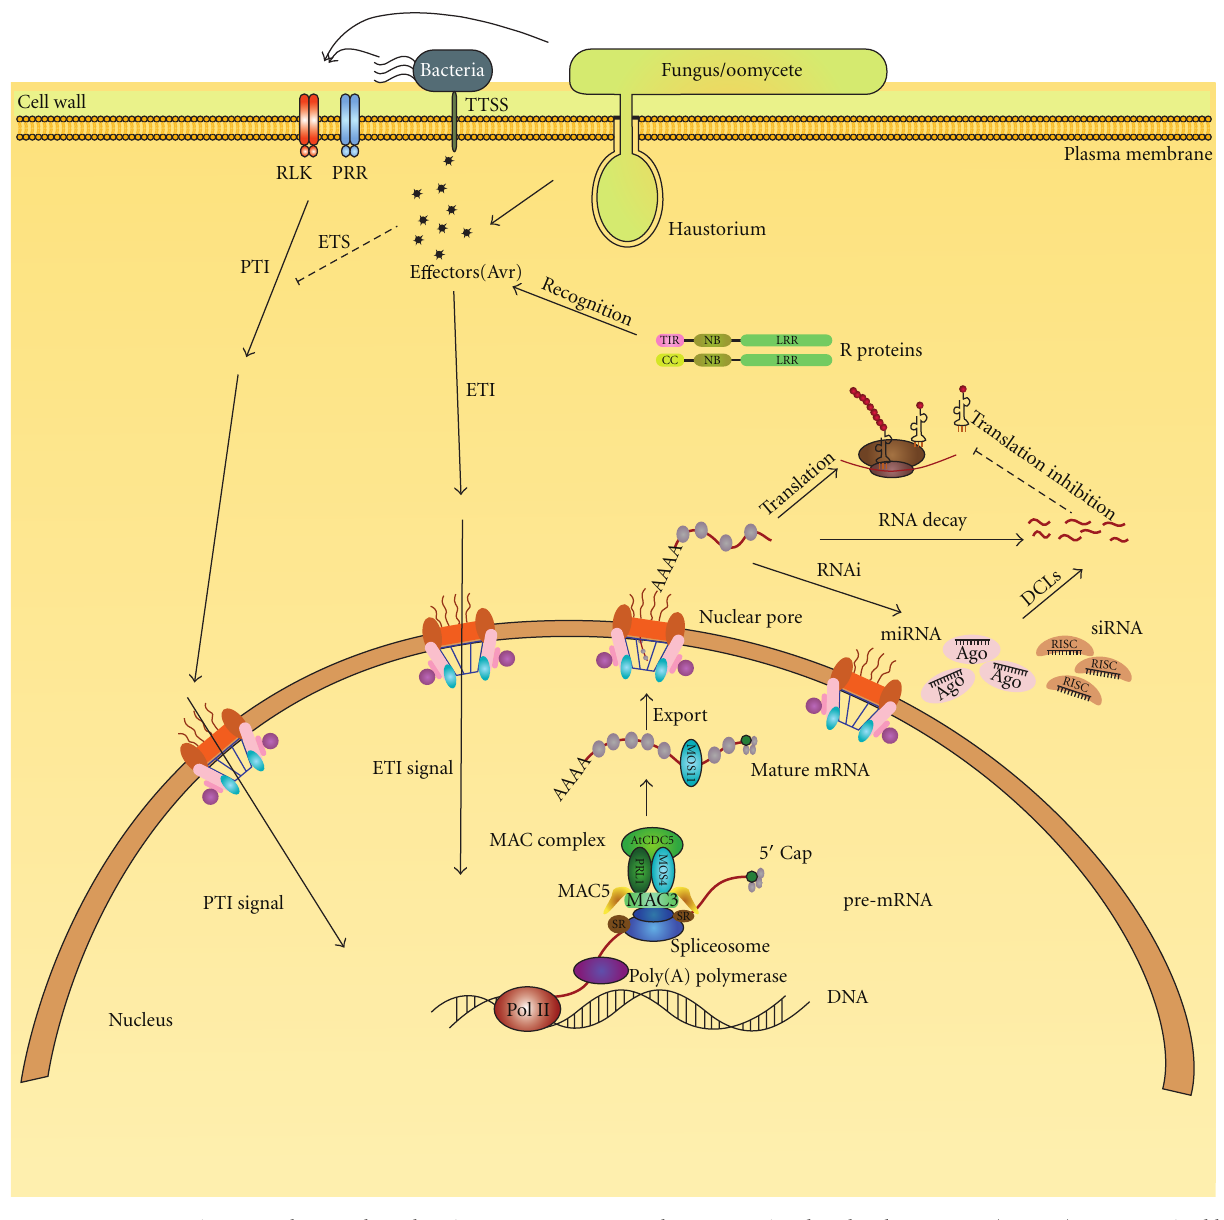
Figure 1: RNA processing steps that regulate plant immune responses. Pathogen associated molecular patterns (PAMPs) are recognized by pathogen recognition receptors (PRRs), which induce signaling cascades and lead to PAMP triggered immunity (PTI). To overcome this, bacterial, oomycete or fungal pathogens release e ff ector molecules that inhibit PTI; this leads to e ff ector-triggered susceptibility (ETS). Plants have evolved Resistance (R) proteins that recognize the e ff ectors and lead to e ff ector-triggered immunity (ETI). PTI and ETI both trigger downstream defence gene activation followed by RNA processing steps that include 3 (cid:2) polyadenylation, splicing, 5 (cid:2) capping and mRNA export. MAC5A/B associate with the MOS4-associated Complex (MAC), which associates with the spliceosome; therefore, MAC5A/B may contribute to mRNA splicing during pathogen defence [2]. MOS11 is also found in the nucleus; however, it is involved with mRNA export [3]. DCL2 and DCL4 are both required in the formation of siRNAs in RNAi, which assists in plant immunity [4, 5]. Similarly, AGO1,